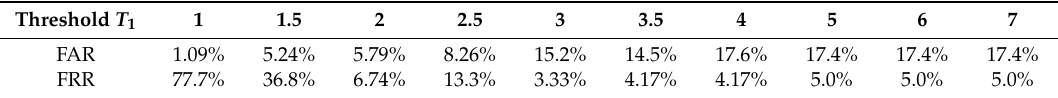
Table 3. Influence of Euclidean distance threshold T 1 .